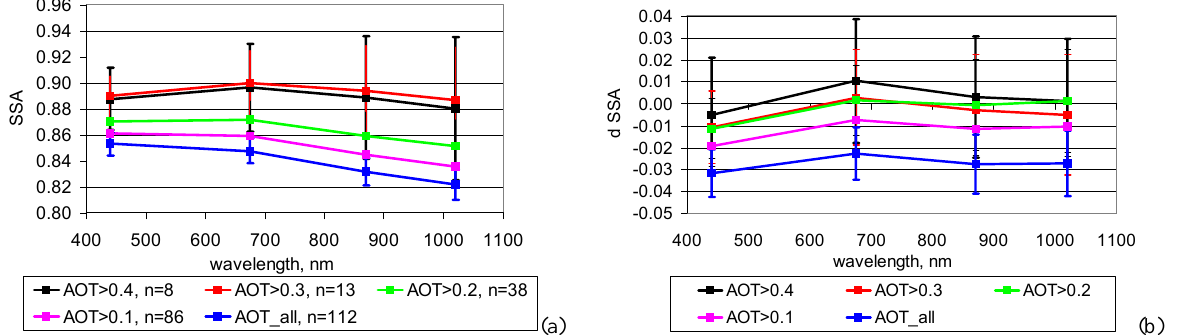
Moscow and Zvenigorod (b) . a/ b/